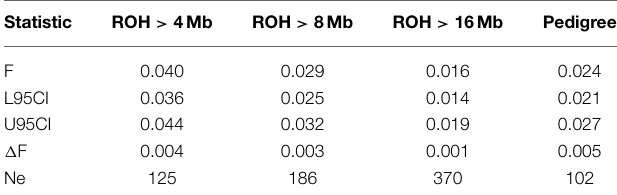
TABLE 1 | Levels of inbreeding (F) with lower and upper 95% confidence intervals (L95CI, U95CI), change of inbreeding per generation ( 1 F) and inbreeding effective population size [Ne, with Ne = 1/(2 1 F)].